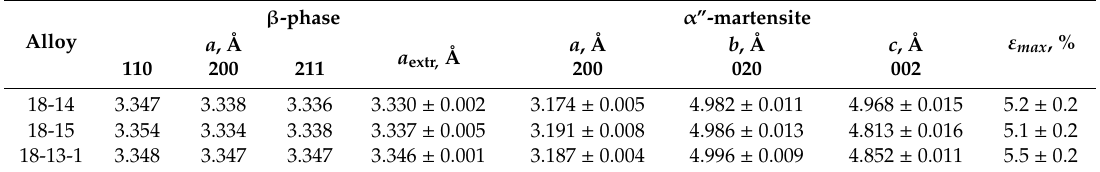
Table 8. Lattice parameters and crystallographic resource of recovery strain ( ε max ) of the 18-14, 18-15, and 18-13-1 alloys.